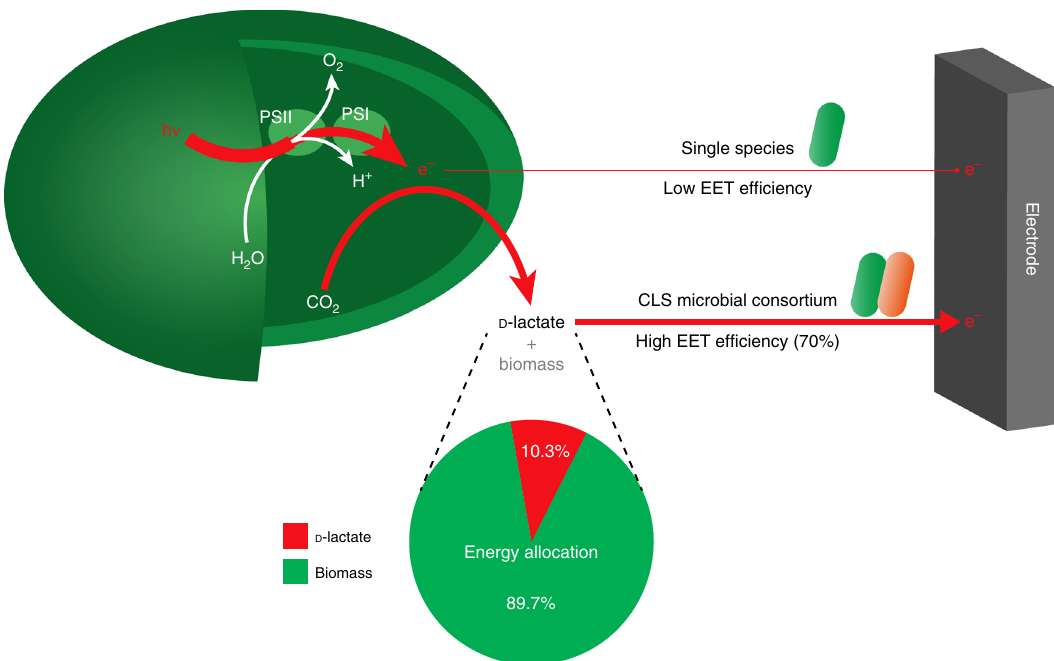
Fig. 7 Electron fl ow comparison of two different types of BPV. One type is based on the single species of cyanobacteria, and another is based on the CLS microbial consortium. The red solid arrows show the routes of electron transfer and the thickness of the arrows indicates the relative fl ux of electrons. In the single species of cyanobacteria, photoexcited electrons are transferred directly to the electrode with a low EET ef fi ciency. In the CLS microbial consortium, photoexcited electrons are diverted to D -lactate by the engineered cyanobacterium, and S. oneidensis releases these electrons to the electrode with a high EET ef fi ciency of about 70%. Solar energy allocation in the strain Syn 2973- omcS - ldh was calculated based on the heat of combustion and shown at the bottom. Source data are provided as a Source Data fi